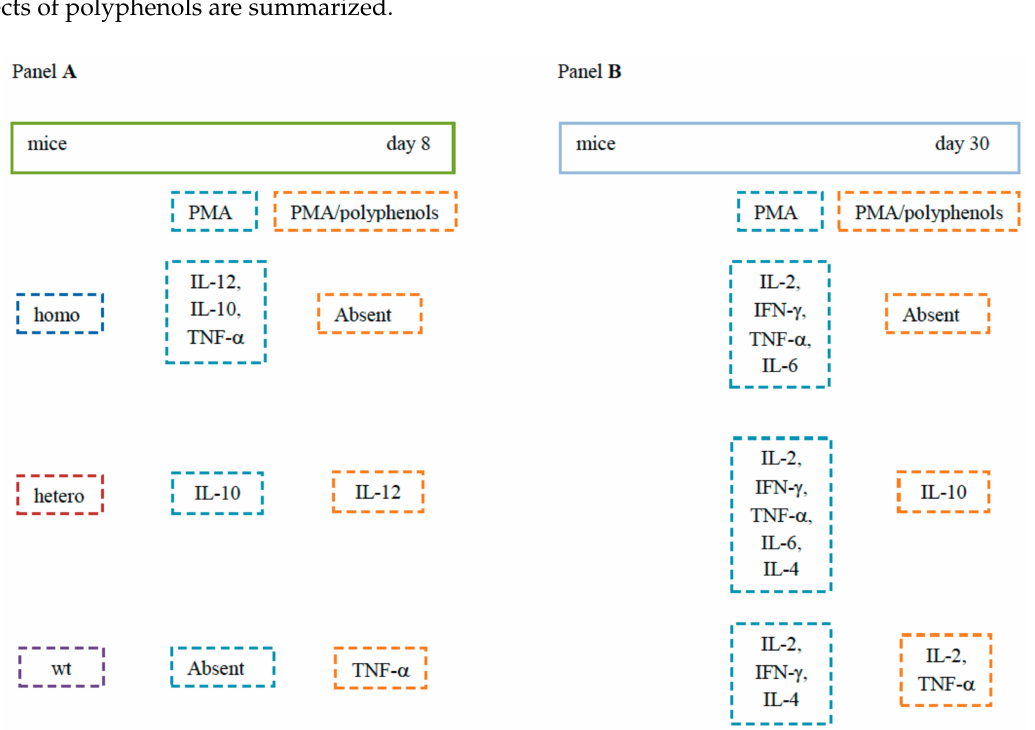
Figure 8. Time of appearance of splenic cytokines and polyphenol e ff ects. In A , at day 8, cytokine release by PMA and PMA / polyphenol-stimulated splenocytes, respectively, is indicated. In homo mice, polyphenols abrogate release of IL-12, IL-10 and TNF- α . In hetero and wt mice, e ff ects are less evident in view of a likely delayed maturation of immune cells. In B , at day 30, cytokine release by PMA and PMA / polyphenol-stimulated splenocytes, respectively, is indicated. Maturation of immune cells is more marked in homo and hetero mice than in wt mice. Polyphenols dampen the release of regulatory and inflammatory cytokines in homo and hetero mice and to a lesser extent in wt